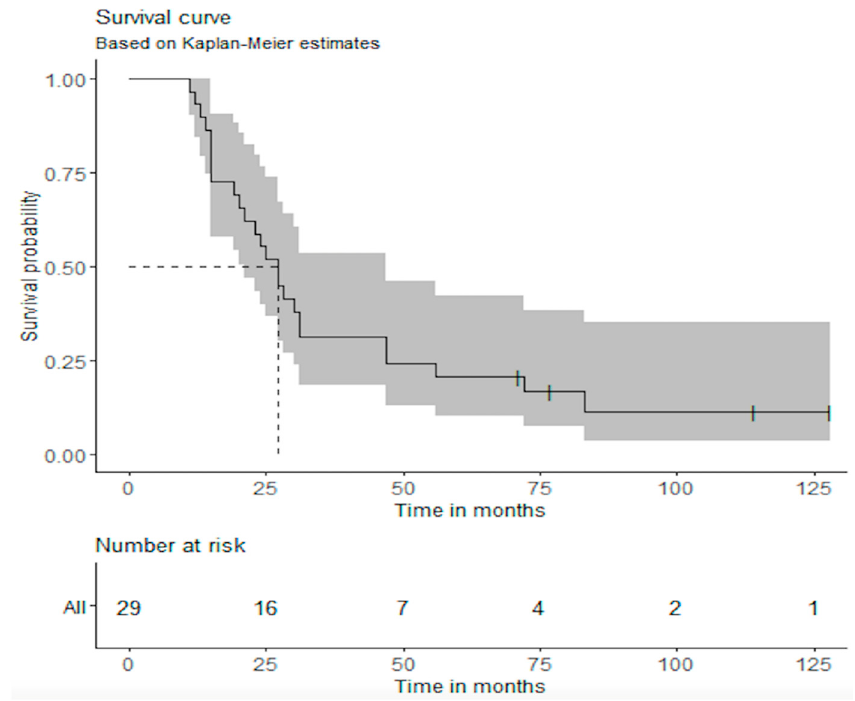
Figure 1. Overall survival of the combined phase I/II trials. Four patients are still alive, at respectively 71, 77, 114, and 128 months. The first two patients were treated with DC vaccinations containing allogeneic tumor lysate; the latter two patients were treated with autologous dendritic cell vaccination combined with low- dose cyclophosphamide; one patient has had a pleurectomy/decortication before the DC vaccination.